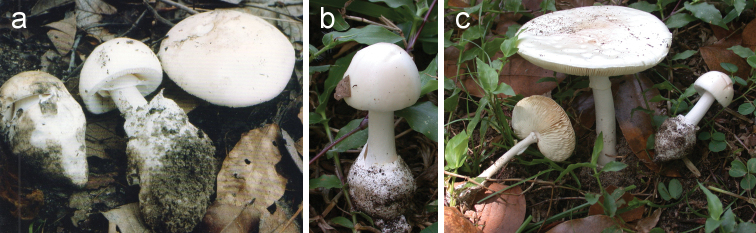
Basidiomata of Amanitaharkonenianaa Saarimäki et al. 1061 (holotypus) b Pirot s.n. (coll. 2014) c Pirot s.n. (coll. 2014).